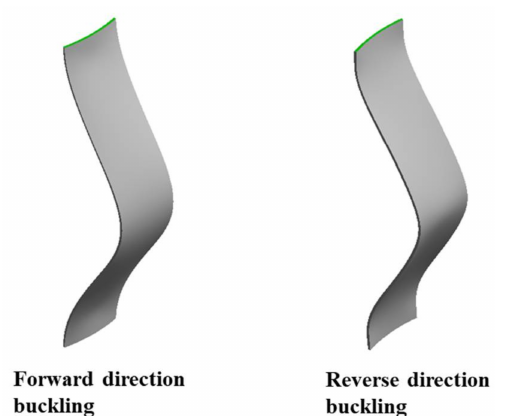
Figure 6. Schematic drawings of two buckling directions for convex tape-shaped